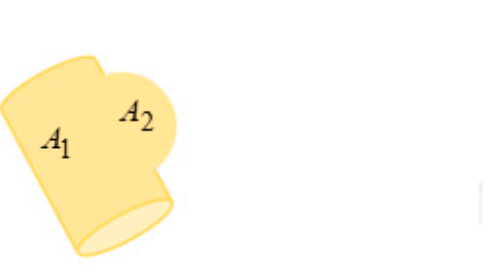
Figure A3. Examples of two composed objects.